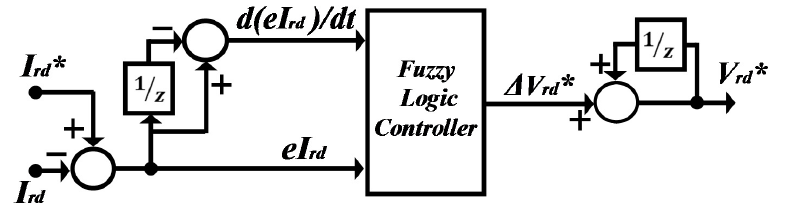
Figure 8. Proposed fuzzy logic controller (FLC).